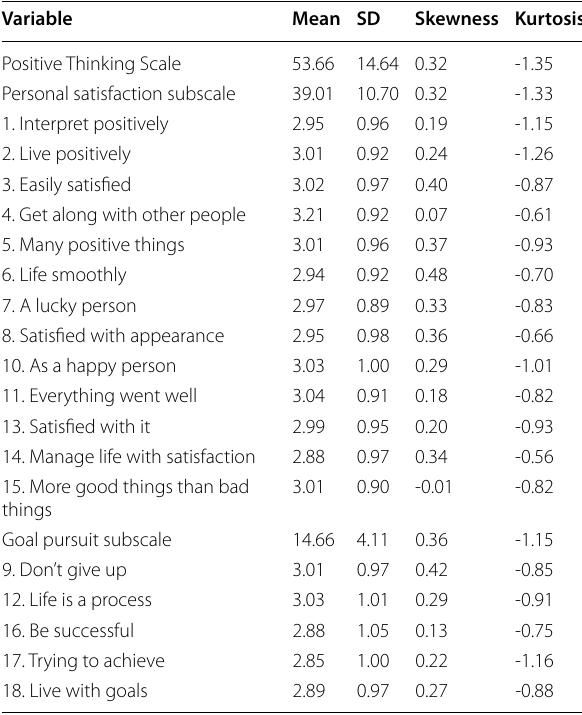
Table 2 Means, standard deviations, skewness, and kurtosis of scale ( n =